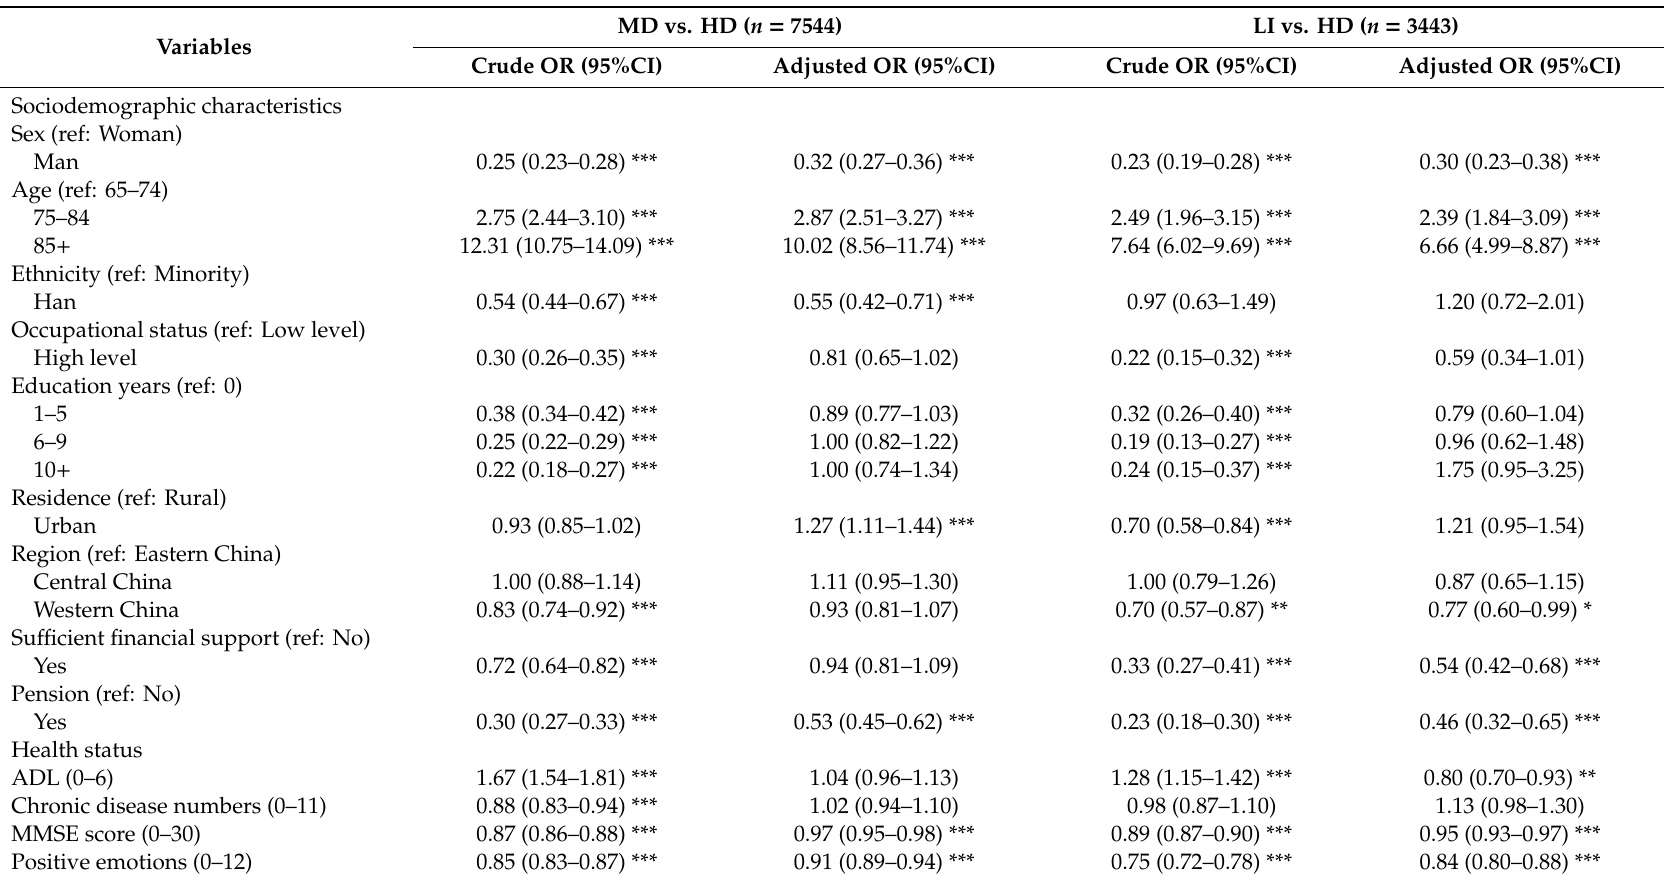
Table 3. Associations of baseline characteristics with social engagement trajectory classes among older adults by univariable and multivariable logistic regression.